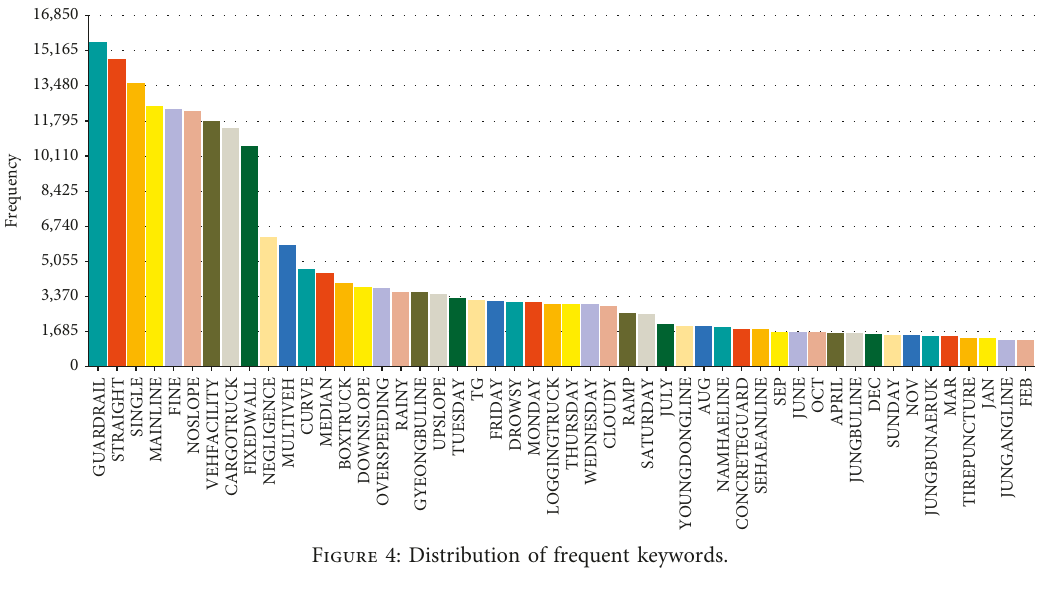
Figure 4: Distribution of frequent